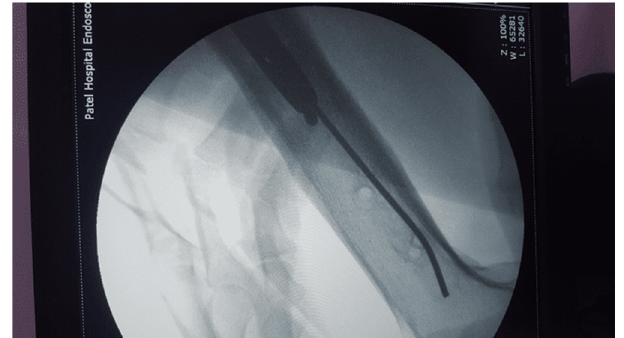
Figure 5. Extraction of the broken nail with plain guide wire remains in situ.